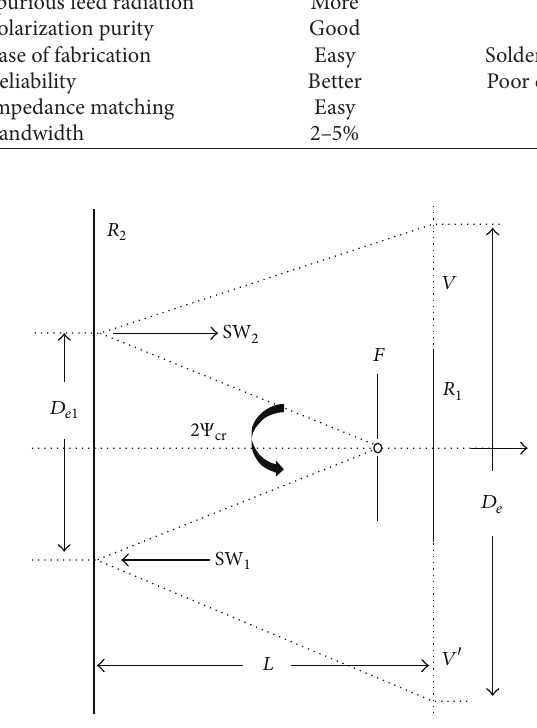
Figure 1: Basic geometry of back fire antenna [1].